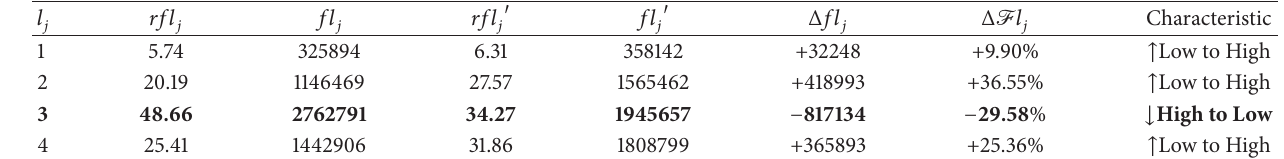
Table 12: Characterization of malicious update attacks on length of data values.